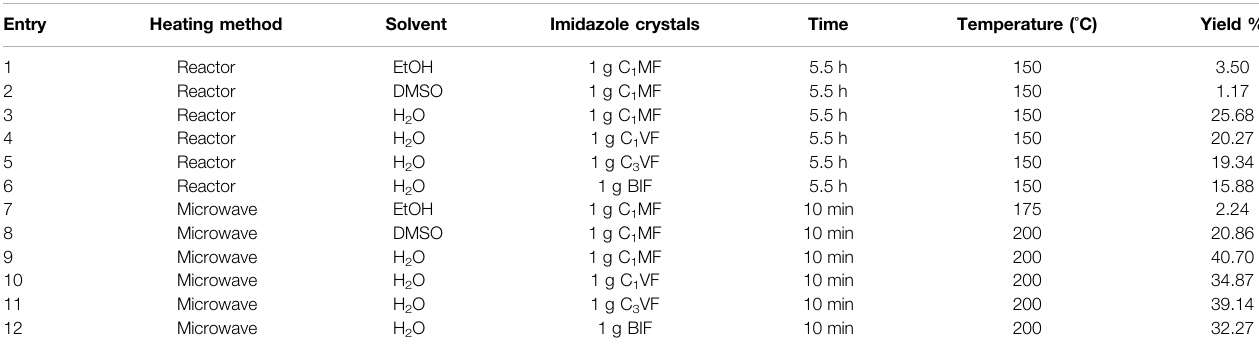
TABLE 1 | The effect of heating method and solvent on reaction. Heating